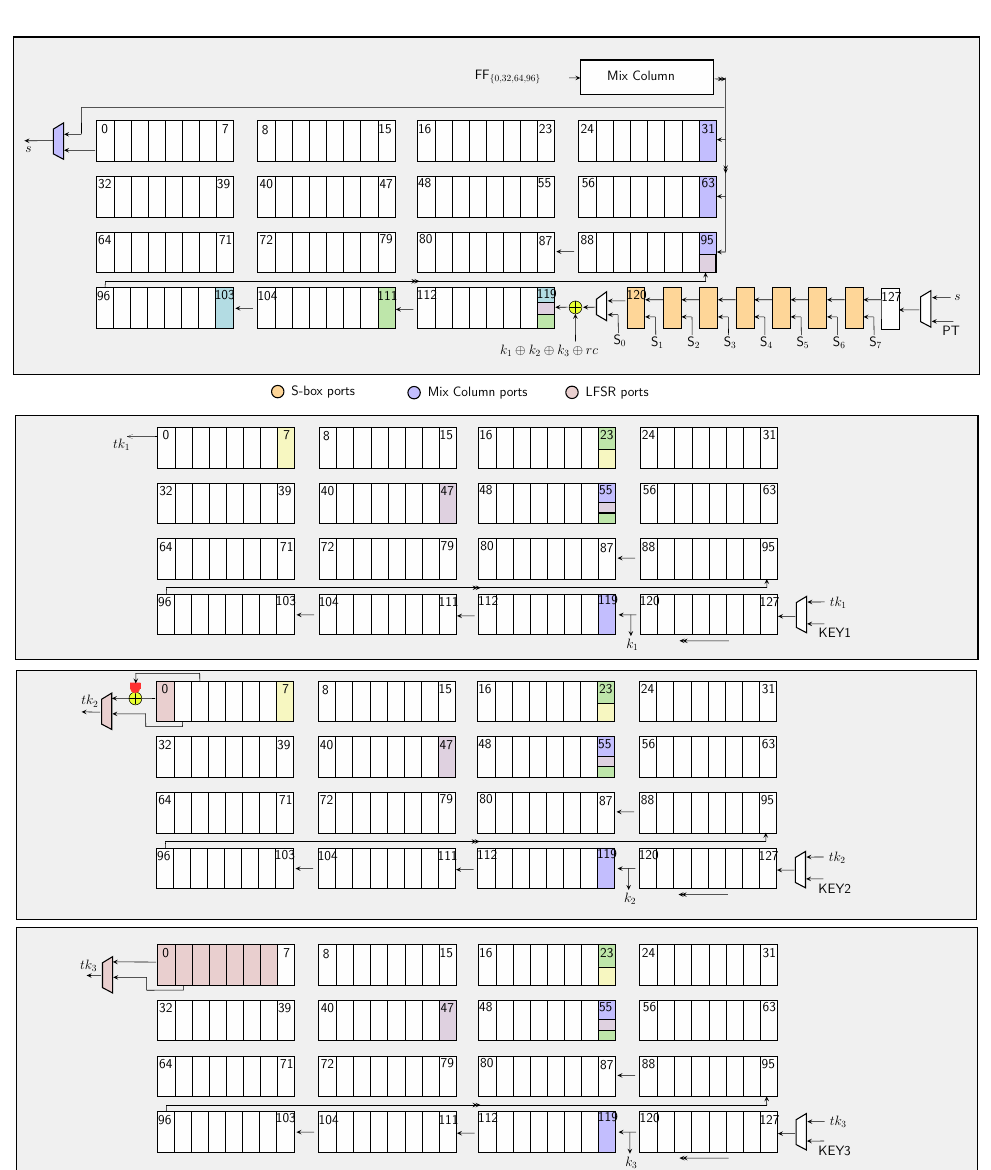
Figure 5: The state (above) and key ( TK 1, TK 2 and TK 3 respectively) pipelines of SKINNY